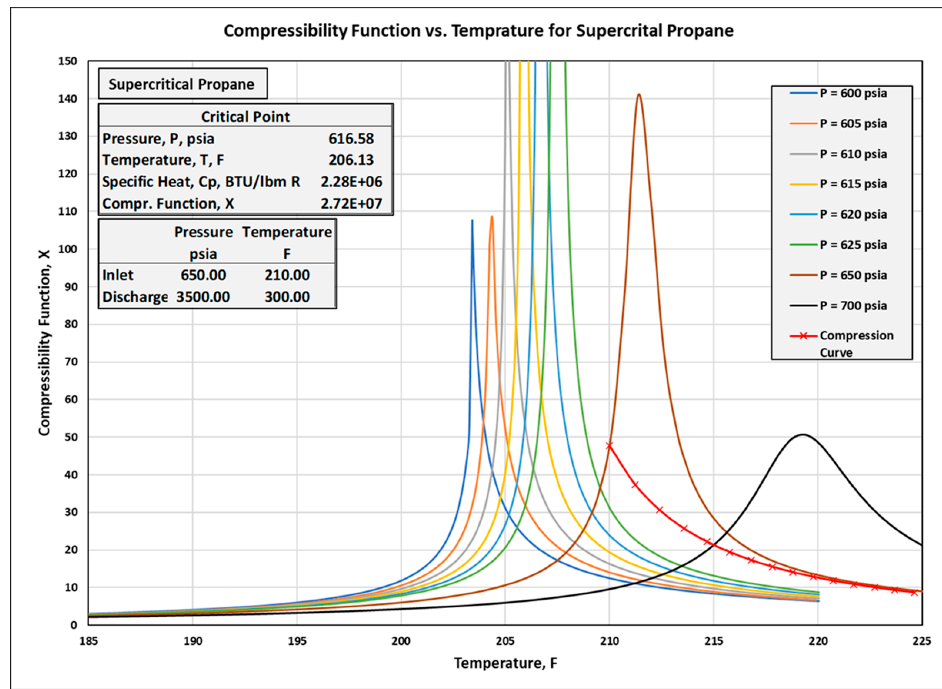
Figure 9. Change of compressibility function, 𝑋 , along the polytropic path for supercritical propane example. Furthermore, the change of compressibility function, 𝑋 , with temperature at different inlet pressures is shown.